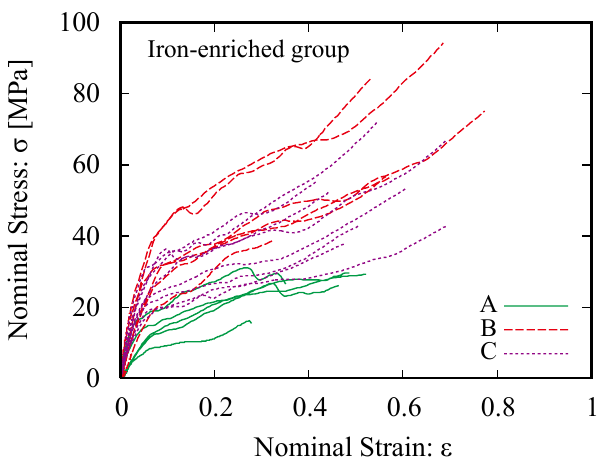
Fig. 12 Stress-strain diagrams of byssal threads in the iron-enriched group.